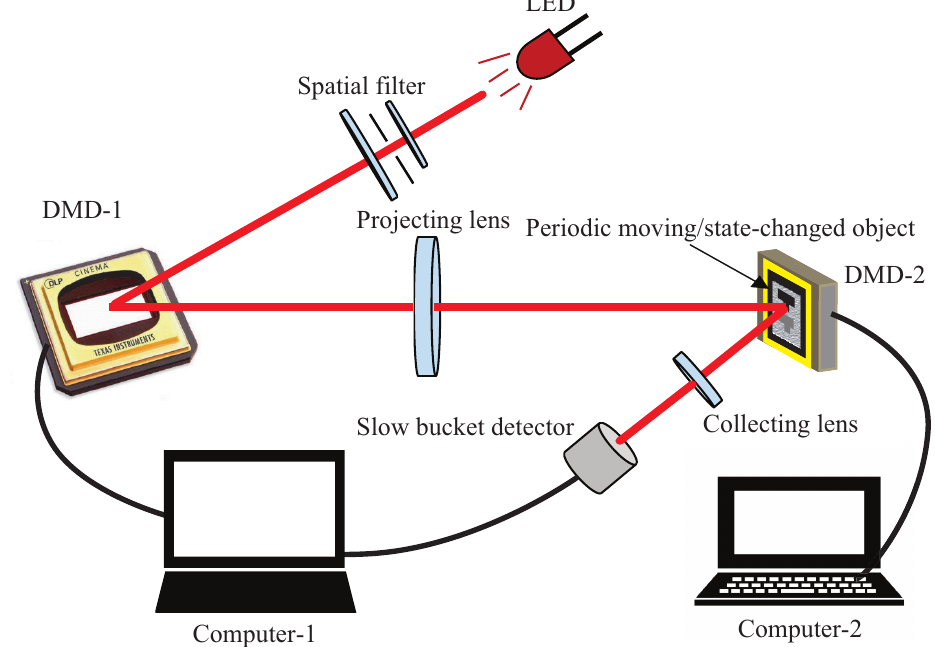
Figure 5. The experimental setup of the